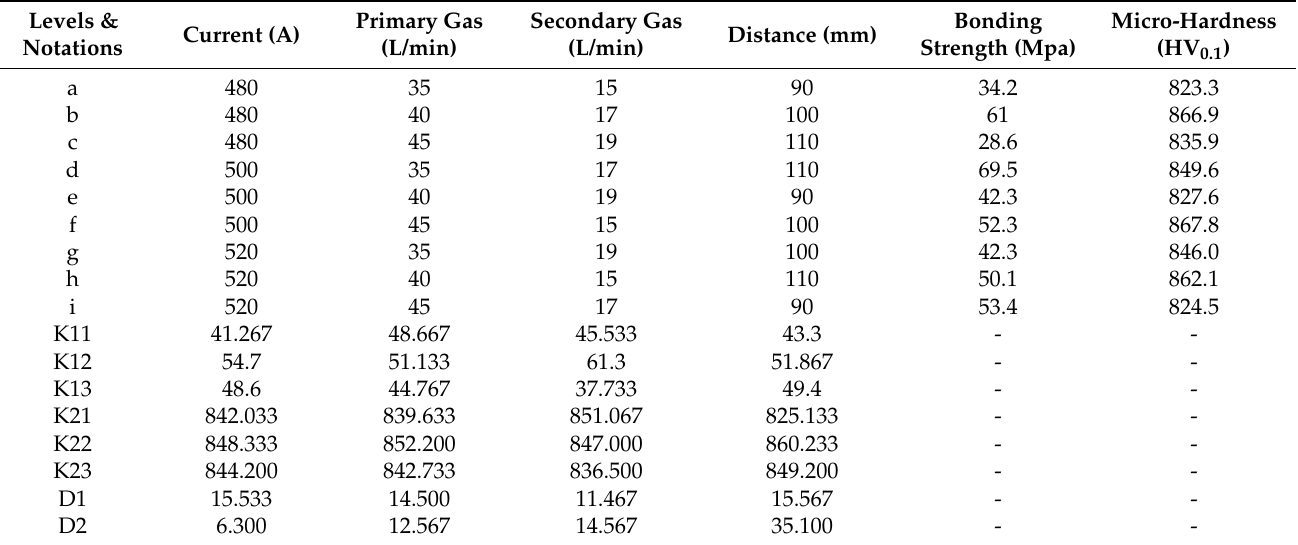
Table 1. Process parameters of the Fe-Cr-B-C coating for plasma spraying and range analysis results of the orthogonal